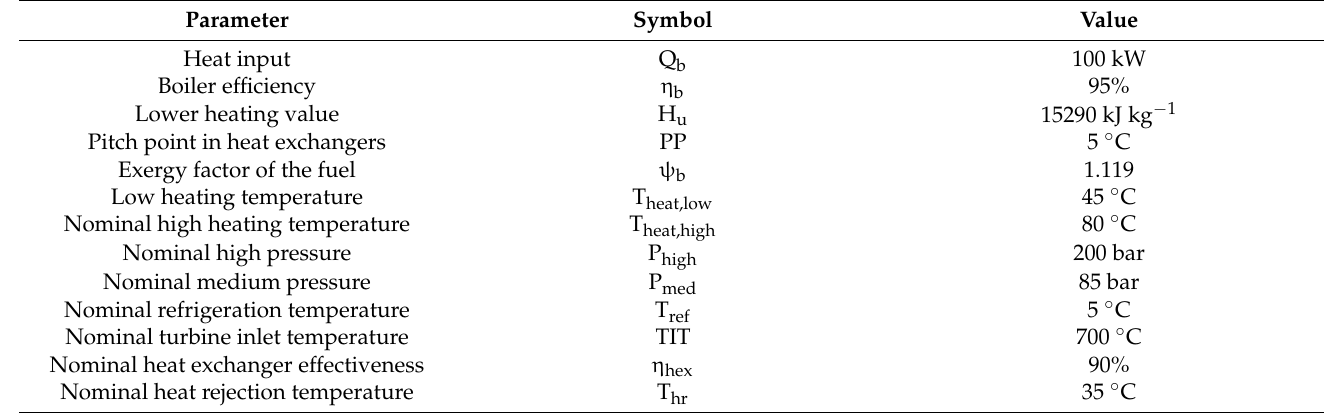
Figure 3. Temperature-specific entropy (T-s) diagram for the studied polygeneration system in nominal operating conditions (logarithmic vertical axis).